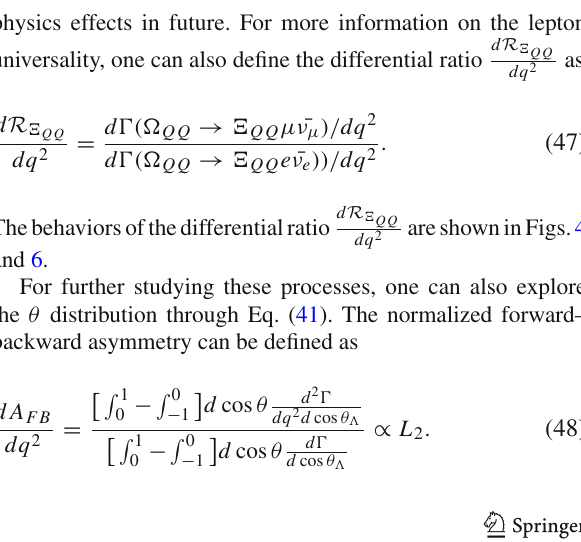
Especially in these s → u semileptonic decays the phase space is very small and q 2 is comparable to the m μ for these